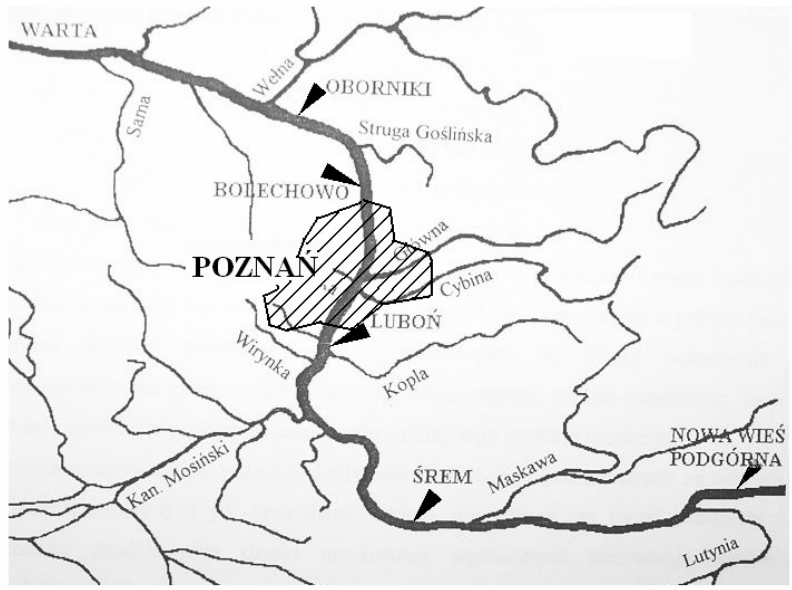
Fig 1. Location of reach of the Warta River included in the study with denoted cross-sections of water quality